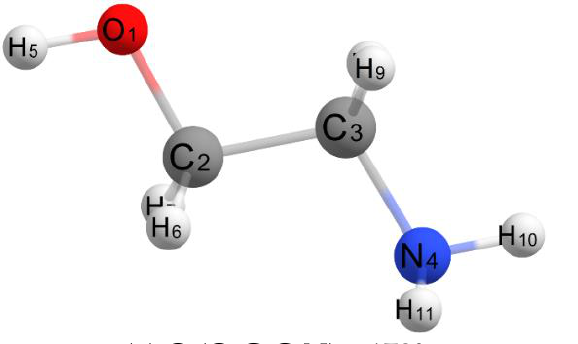
Figure 1. IR absorption spectra of ( a ) anhydrous MEA; ( b ) MEA aqueous solutions of various con- centrations (12%, 15%, 20%, and 30%, respectively) recorded at room temperature. Quantum-chemical calculations of an isolated MEA molecule in vacuum and water indicate the presence of two stable isomers (Figure 2a,b), one of which (a) has an almost flat transoidal structure (dihedral angle O-C-C-N is 178°), while the second (b), which is only 0.48 kcal/mol more favorable in terms of energy, has a non-planar gauche structure with a dihedral angle Q (O-C-C-N) = 64°.